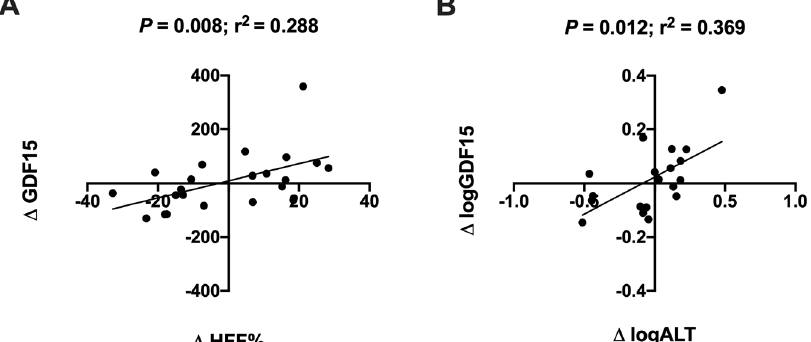
Fig. 2 Change in GDF15 in youth that increased or decreased in HFF% by at least 30% of original in a two-year period. A Correlation between change in HFF% and change in plasma GDF15 concentrations. B Correlation between change in logALT concentrations and change in logGDF15 concentrations. P -values and r 2 values are from Spearman rank